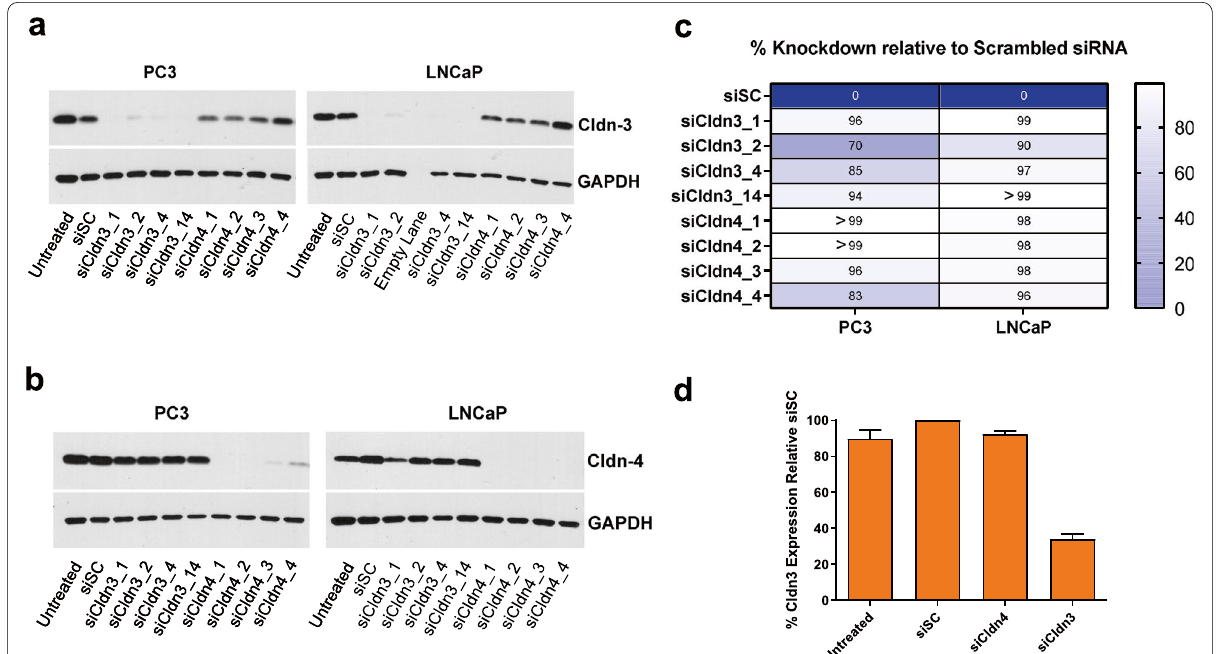
Fig. 2 Knock down of Cldn3 and Cldn4 in human prostate cancer cells. Western blots showing the effects of Cldn3 siRNAs (siCldn3) and Cldn4 siRNAs (siCldn4) on the expression of ( a ) Cldn3 and ( b ) Cldn4 respectively, in human PC3 and LNCaP prostate cancer cells after 72 h. Four Cldn3 and Cldn4 siRNAs were tested. c A heatmap demonstrates the percent knockdown (i.e., Color scale is used where white represents a 100% knockdown of protein expression and dark blue represents a 0% knockdown of protein expression) for each siRNA target sequence for PC3 and LNCaP prostate cancer cells. d Relative Cldn3 protein levels in LNCaP prostate cancer cells after 2 weeks of siCldn3 and siCldn4